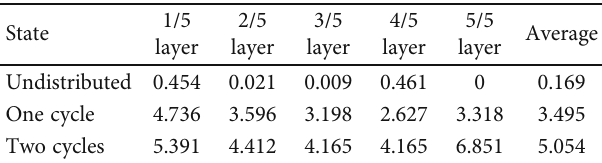
Table 4: Porosity at di ff erent depths of the sample varies with the number of wet and dry